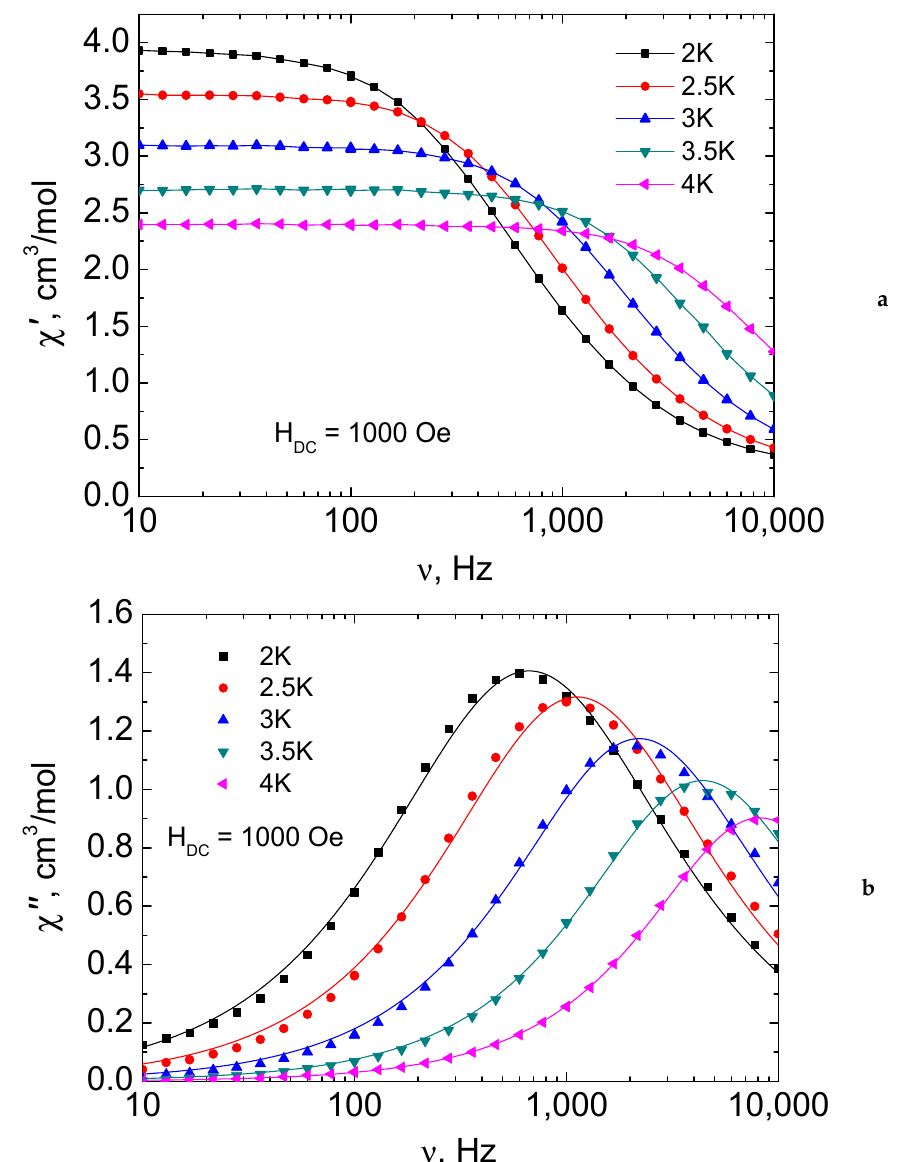
Figure 7. Frequency dependences of the real ( χ (cid:48) , ( a )) and imaginary ( χ ”, ( b )) components of ac-